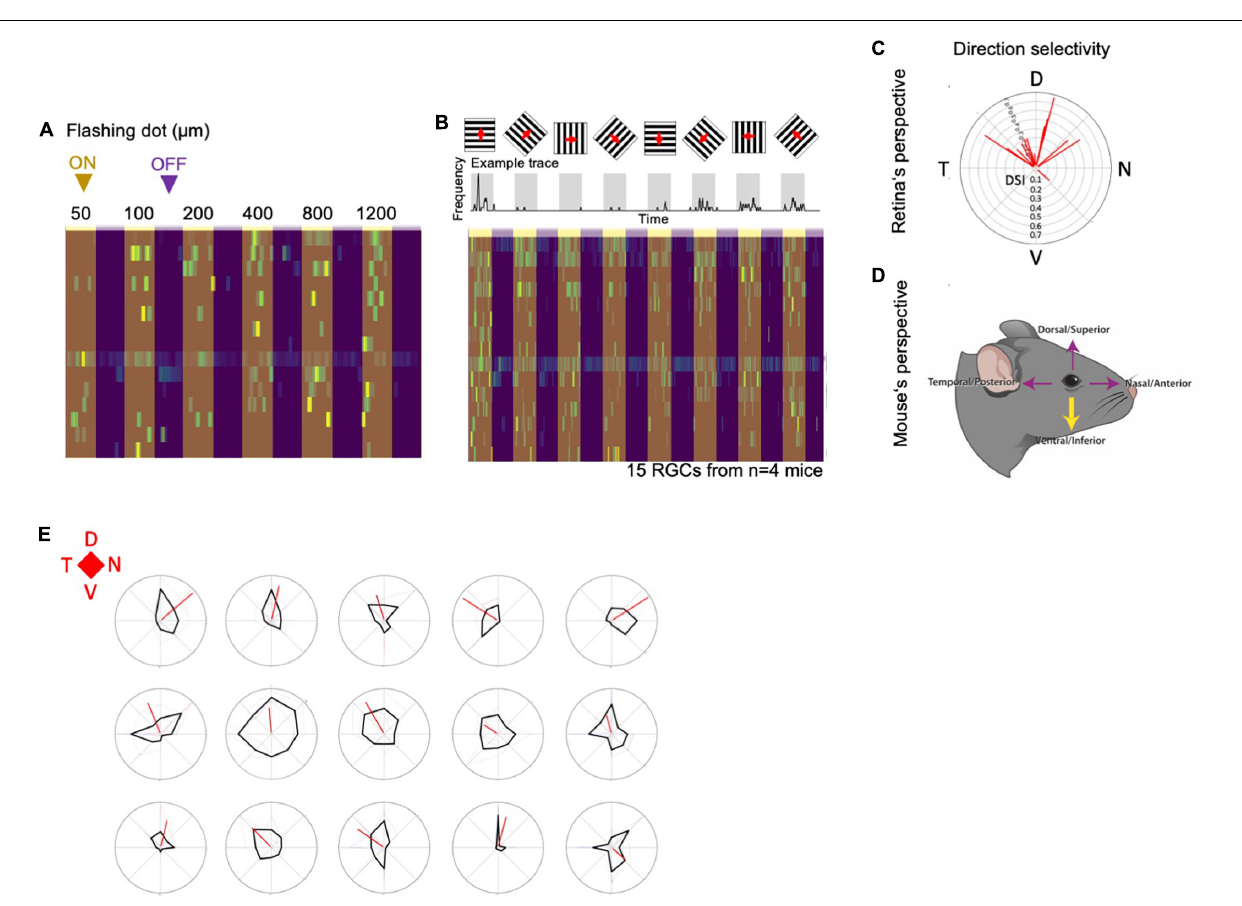
FIGURE 6 | MTN-projecting Flrt3-RGCs are a homogeneous downward ON-DSGC subpopulation. (A) Heatmap plot showing the frequency of firing in cell-attached MTN-projecting Flrt3-RGCs while showing a flashing dot with different diameters (50–1,200 µ m). (B) Top: Scheme representing the recordings of MTN-projecting Flrt3-RGCs firing rate while displaying a moving grid in eight different directions. The frequency plot shows the average frequency of firing. Bottom: The heatmap plot shows the individual frequencies for each neuron patched for each moving grid displayed. N = 15 RGCs from 4 animals. (C) Polar plot showing the direction selectivity of the RGCs recorded from the retina’s perspective. N = 15 RGCs from 4 animals. (D) Cartoon showing the mouse’s perspective of the moving object. (E) Direction selectivity plots of fifteen different MTN-Flrt3-RGCs. N = 15 cells from 4